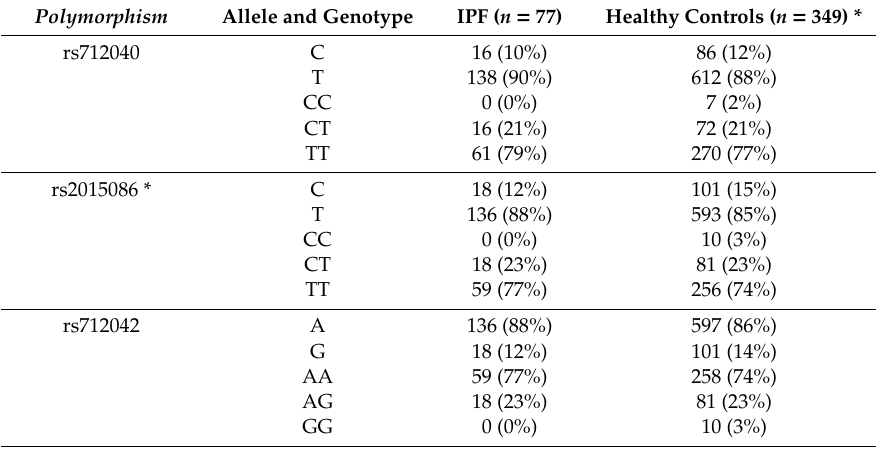
Figure 1. Linkage Disequilibrium (LD) map of four SNPs in the CCL18 gene: rs712040 (location: CCL18 promotor), rs2015086 (location: CCL18 promotor), rs712042 (location: CCL18 intron), rs712044 (location: CCL18 intron). The dark squares represent high r2 values and the triangle represents a haplotype block. Table 2. Allele carrier and genotype frequencies in patients with IPF and healthy